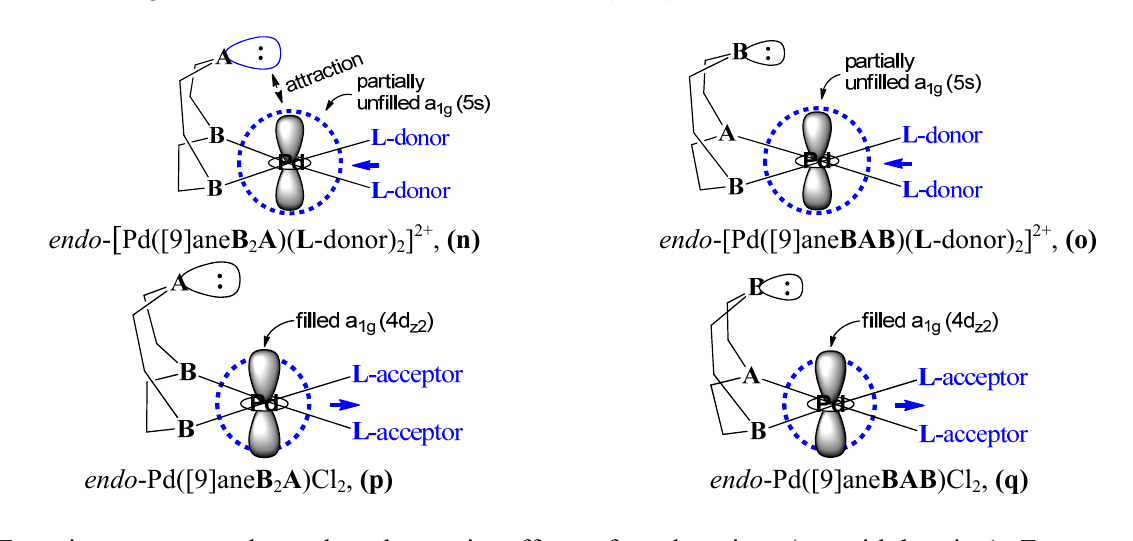
Figure 4. The axial orbital interaction between the σ -donor of the soft A site (or hard B (5s)-orbital is influenced by the electronic property of the site) and the partially unfilled a 1g trans L- ligand and the size of the σ -donor of A (or B